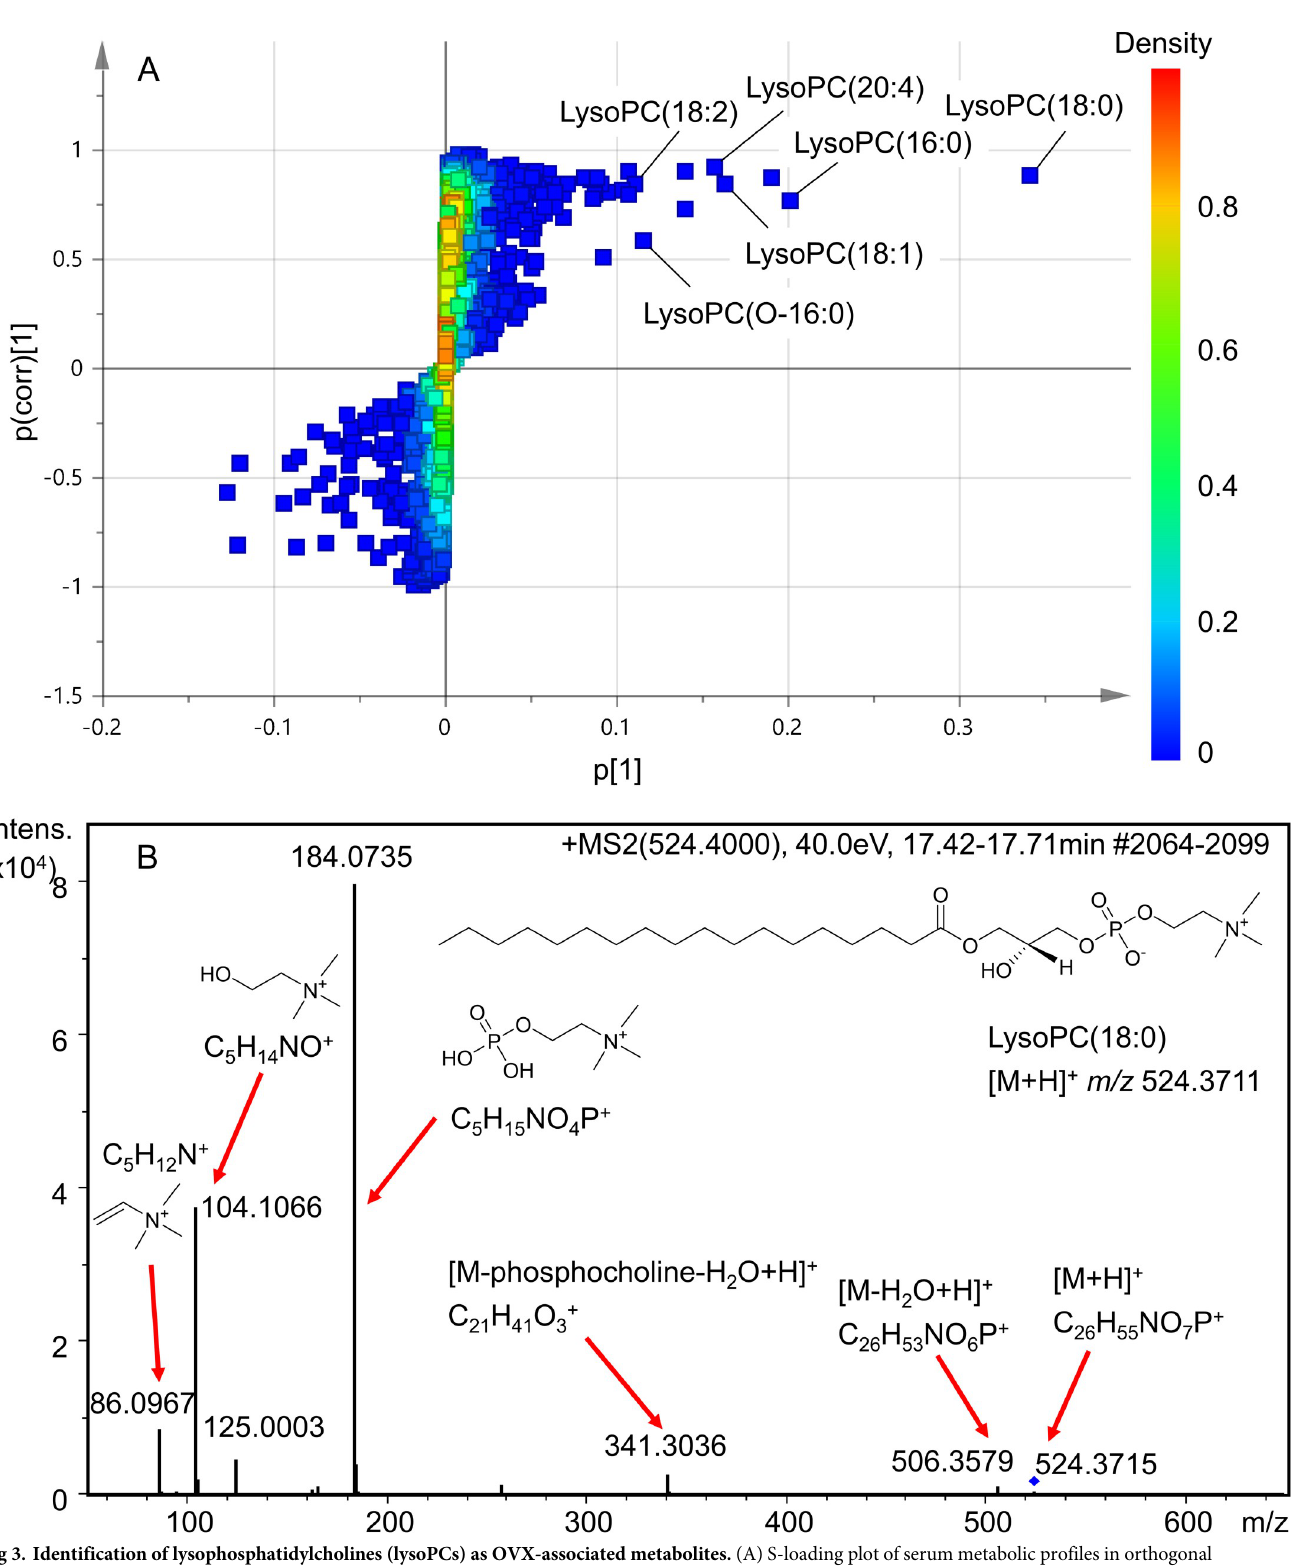
Fig 3. Identification of lysophosphatidylcholines (lysoPCs) as OVX-associated metabolites. (A) S-loading plot of serum metabolic profiles in orthogonal projection to latent structure with discriminant analysis (OPLS-DA). Each square represents a metabolite feature. The upper right and lower left quadrant contains metabolite features with increased and decreased levels in OVX compared to SHAM samples, respectively. Heat scale (Density) indicates Z-score , ranging from